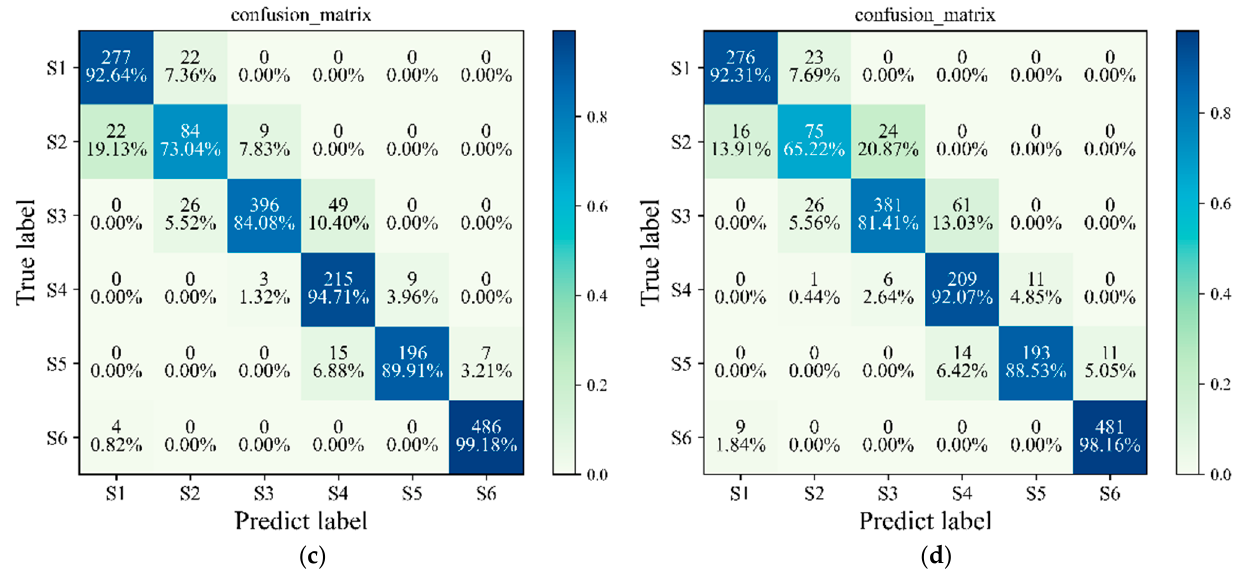
Figure 15. Confusion matrices for the ( a ) NHMM, ( b ) HMM, ( c ) LSTM, and ( d ) SVM models.